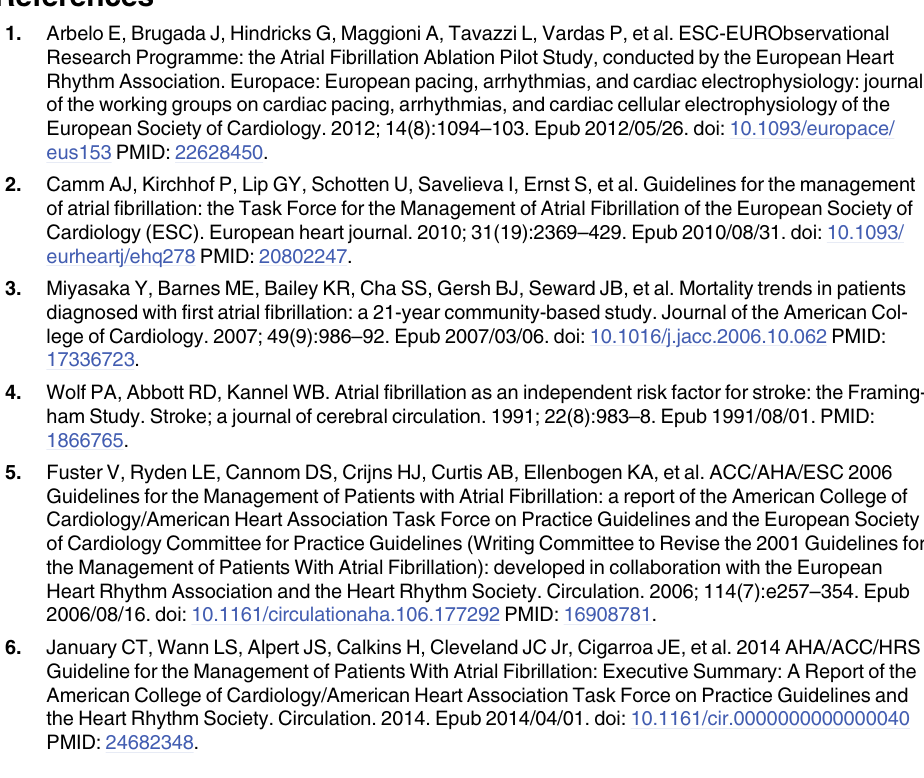
S16 Fig. A forest plot of comparison: changes in left atrial diameter (LAD) pre-ablation and post-ablation during follow-up more than 12 months. (TIF) S17 Fig. A forest plot of comparison: changes in maximum left atrial volume (LAVmax) pre-ablation and post-ablation during follow-up more than 12 months. (TIF) S18 Fig. A forest plot of comparison: changes in minimum left atrial volume (LAVmin) pre-ablation and post-ablation during follow-up more than 12 months. (TIF) S19 Fig. A forest plot of comparison: changes in left atrial ejective fraction (LAEF) pre- ablation and post-ablation during follow-up more than 12 months.